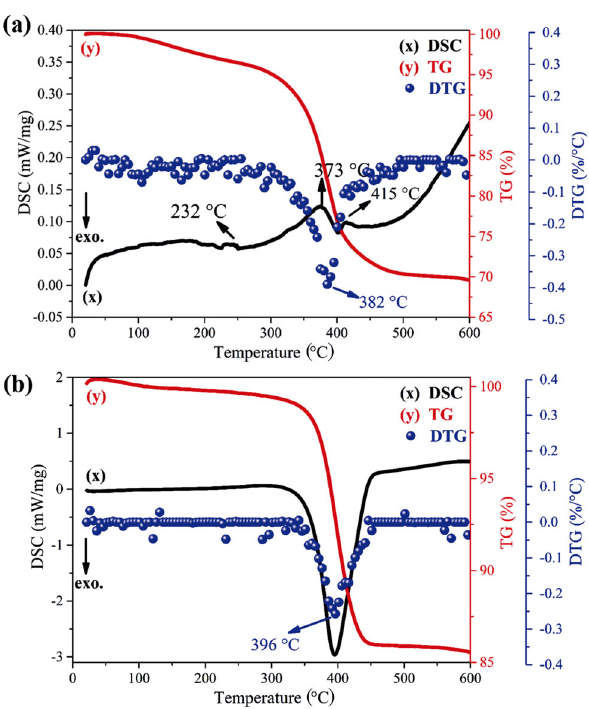
Fig. 6 (a) TG–DSC curves for the printed green body tested in N 2 and (b) the vacuum-debound body tested in